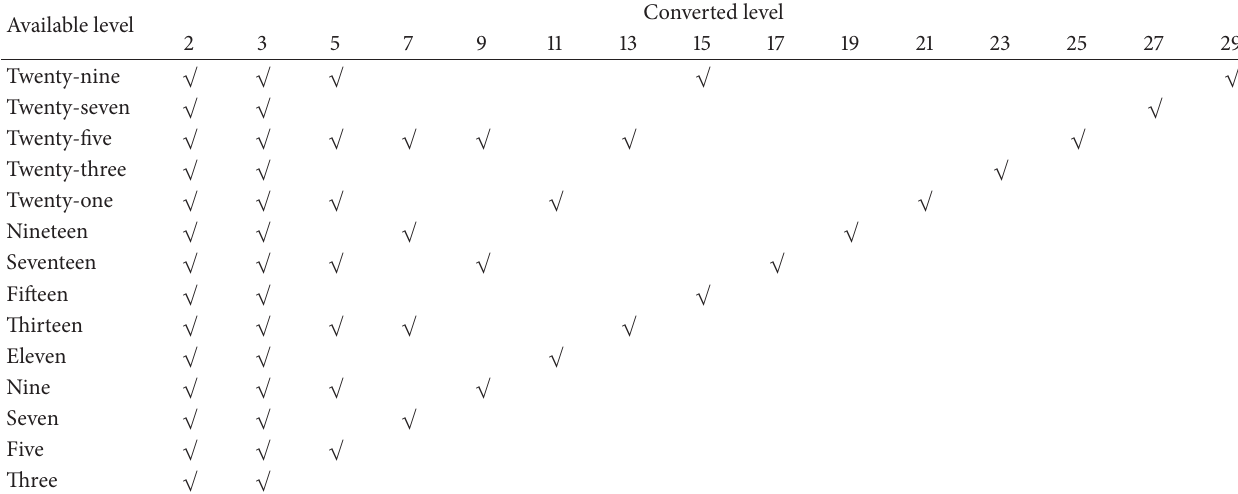
Table 1: Possible converted level from available inverter.